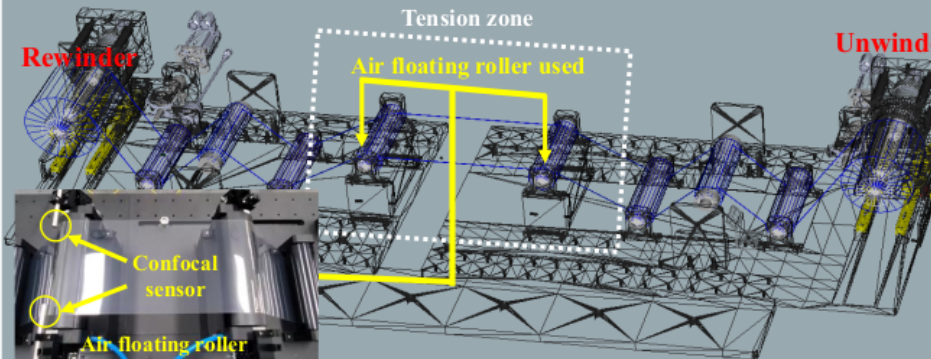
Figure 12. Air floating roller set up in the tension zone.